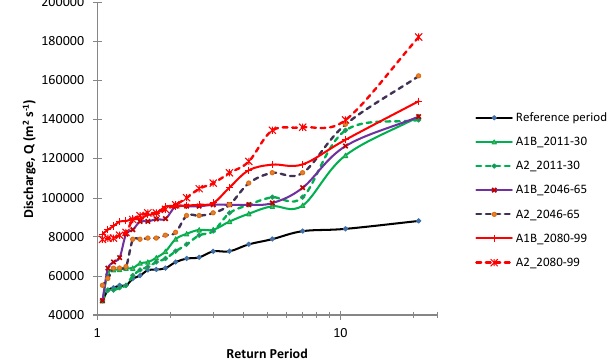
Fig. 7. 7-day low flow for different return periods for different sce- nario’s and time slices as obtained from a weighted average of 12 model outputs.